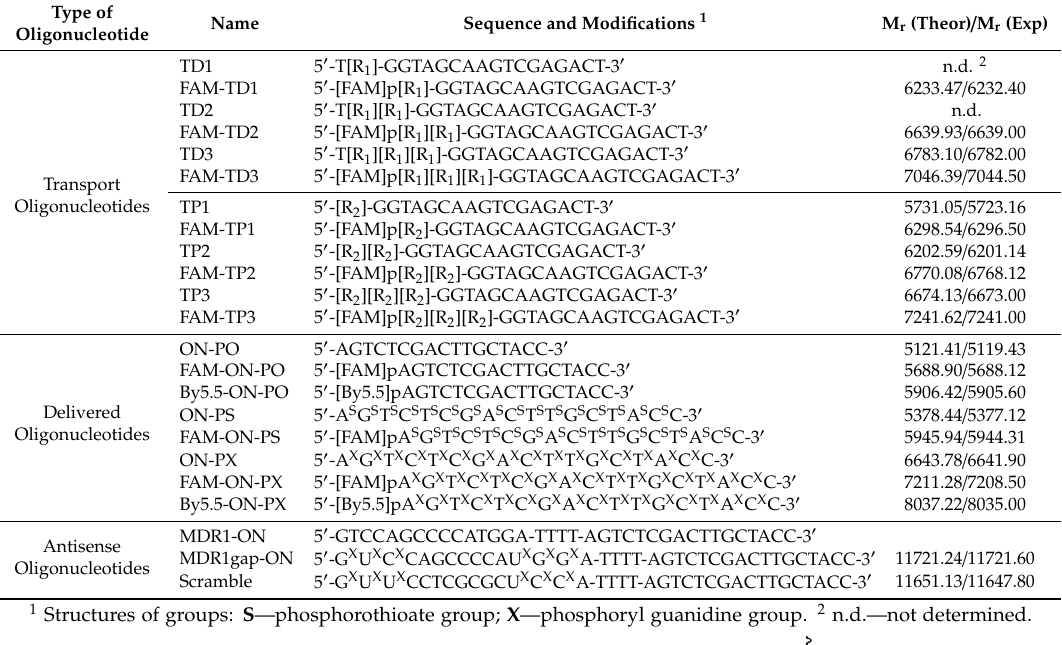
Table 1. Sequences, designations, and modifications of transport and antisense oligonucleotides used in the study.